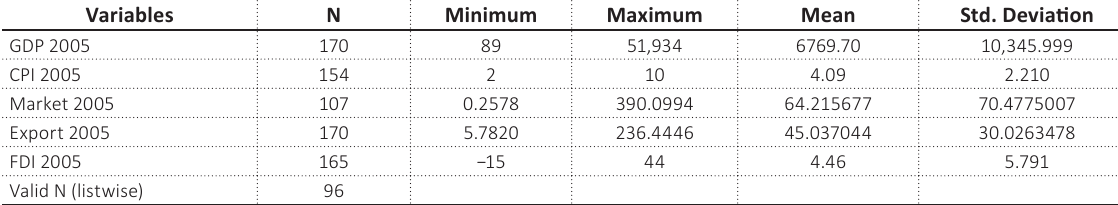
Table 4. Descriptive statistics for 2005